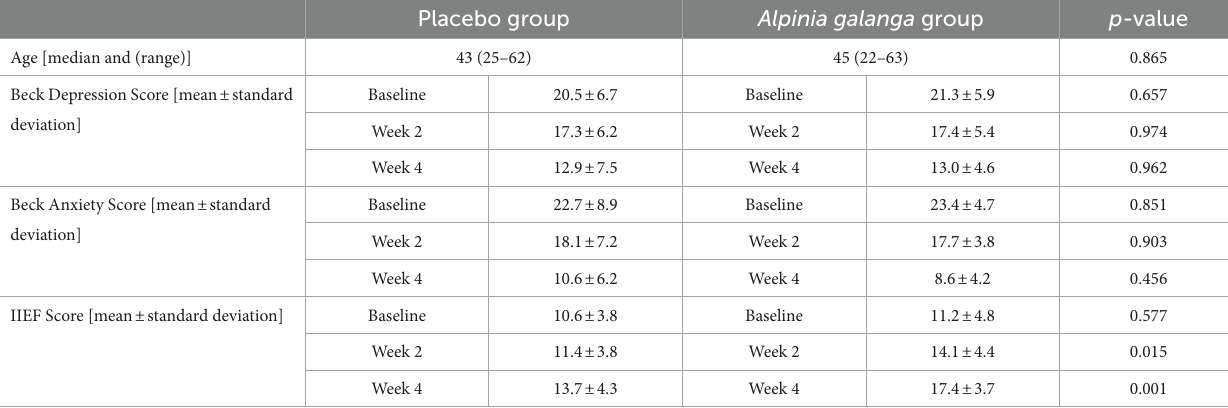
TABLE 1 Comparison of the placebo group and the Alpinia galanga group.